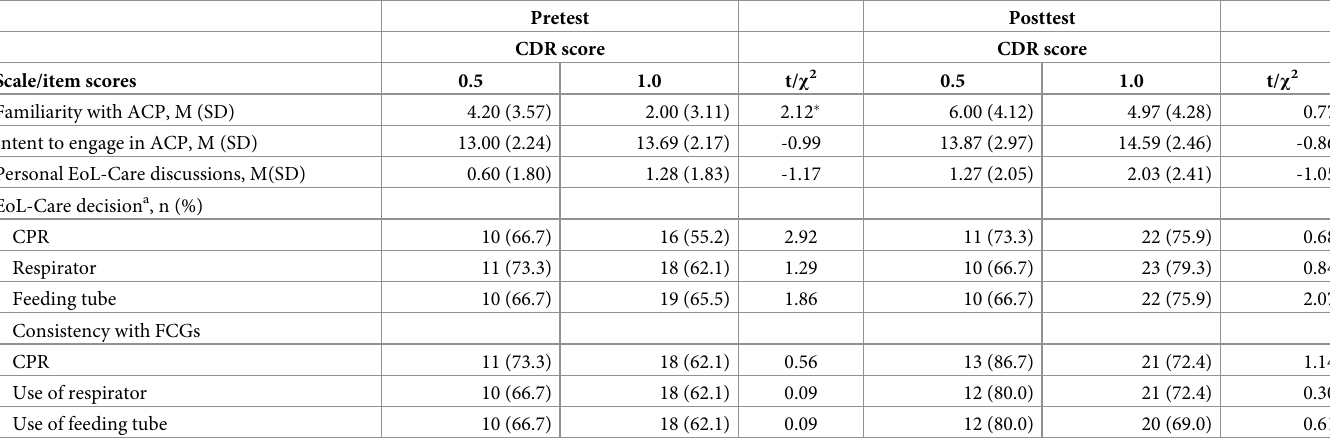
Table 7. Comparison of pretest/posttest scale scores between PWCIs with different CDRs (n = 44).